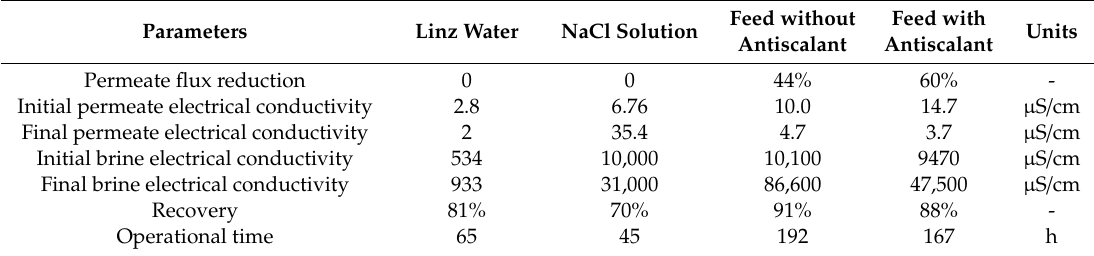
Table 5. Summary of the results obtained for various feed